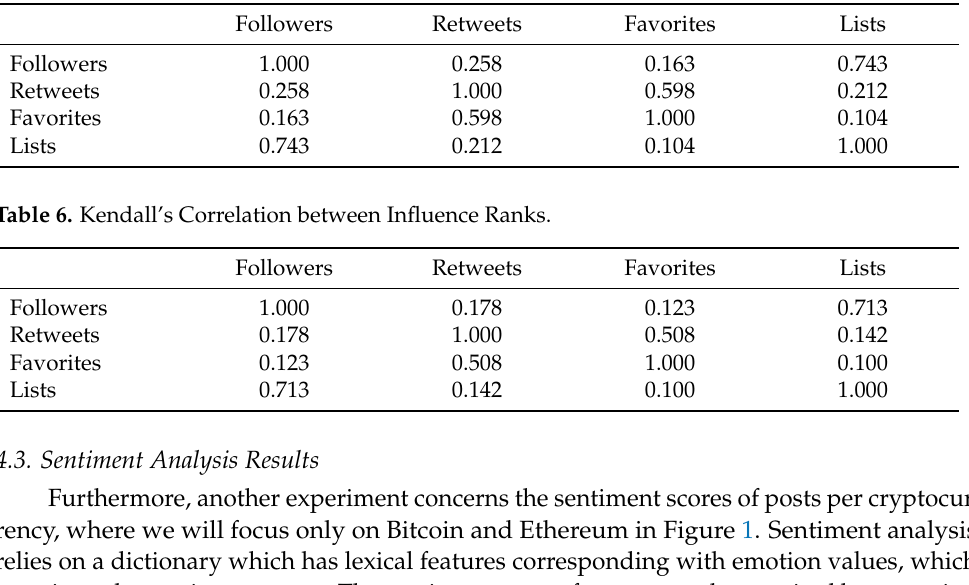
Table 5. Pearson’s Correlation between Influence Ranks.